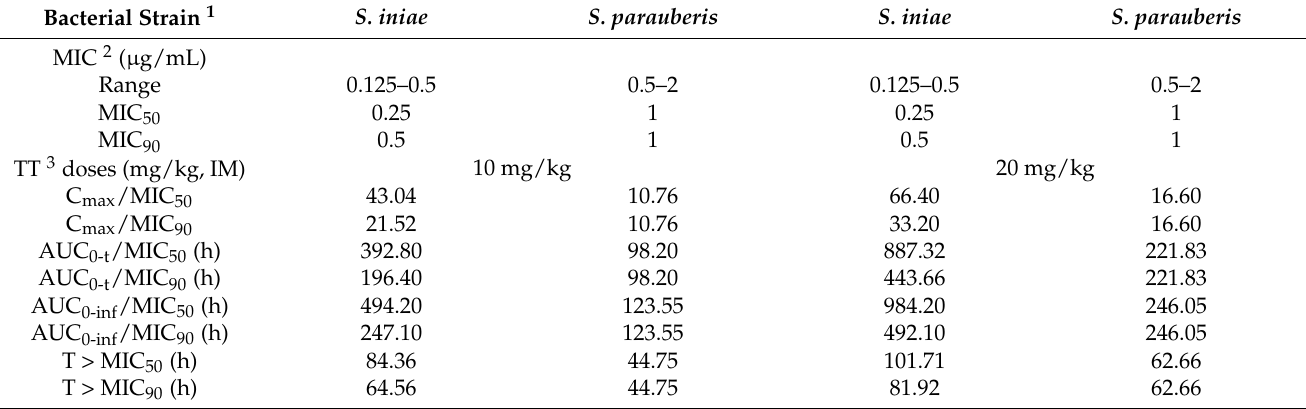
Table 4. Pharmacokinetic-pharmacodynamic (PK/PD) integration of tylosin tartrate based on pharmacokinetic data in olive flounder and in vitro MICs. Bacterial Strain 1